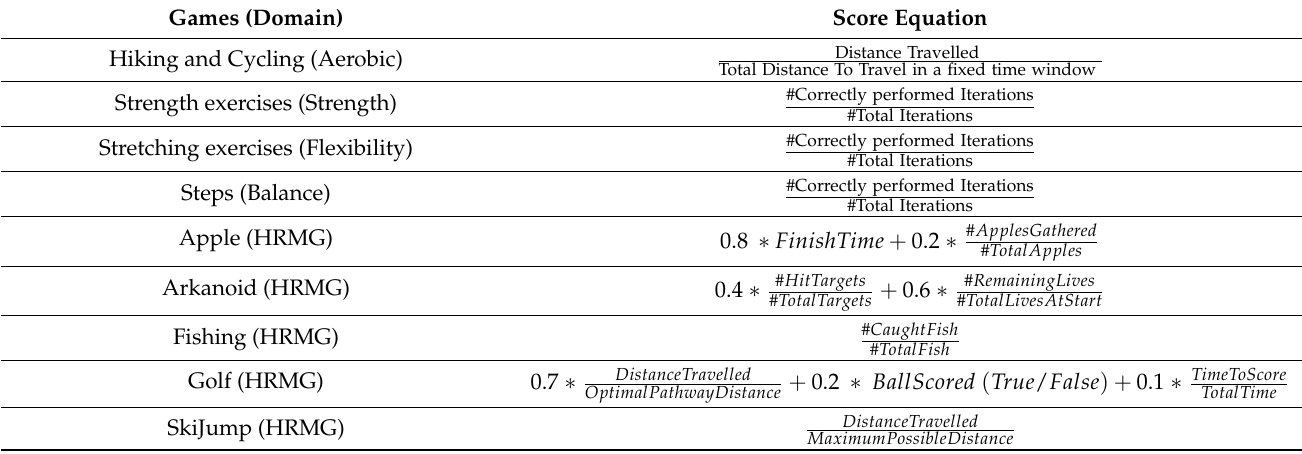
Table 1. Weighted metrics used for scoring. More than one game contributes to the score of each domain. Games